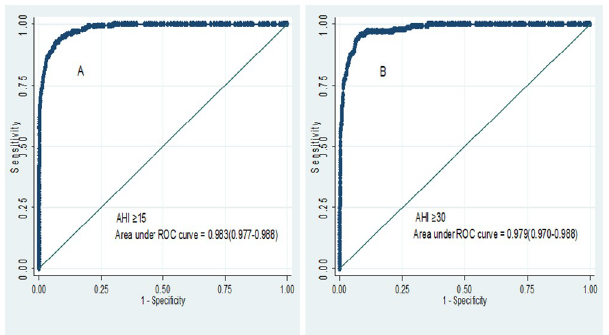
Fig 2. Receiver operating curve for oxygen desaturation index (A and B) at AHI � 15 and AHI � 30 events per hour respectively. Abbreviations: AHI, apnea-hypopnea index.